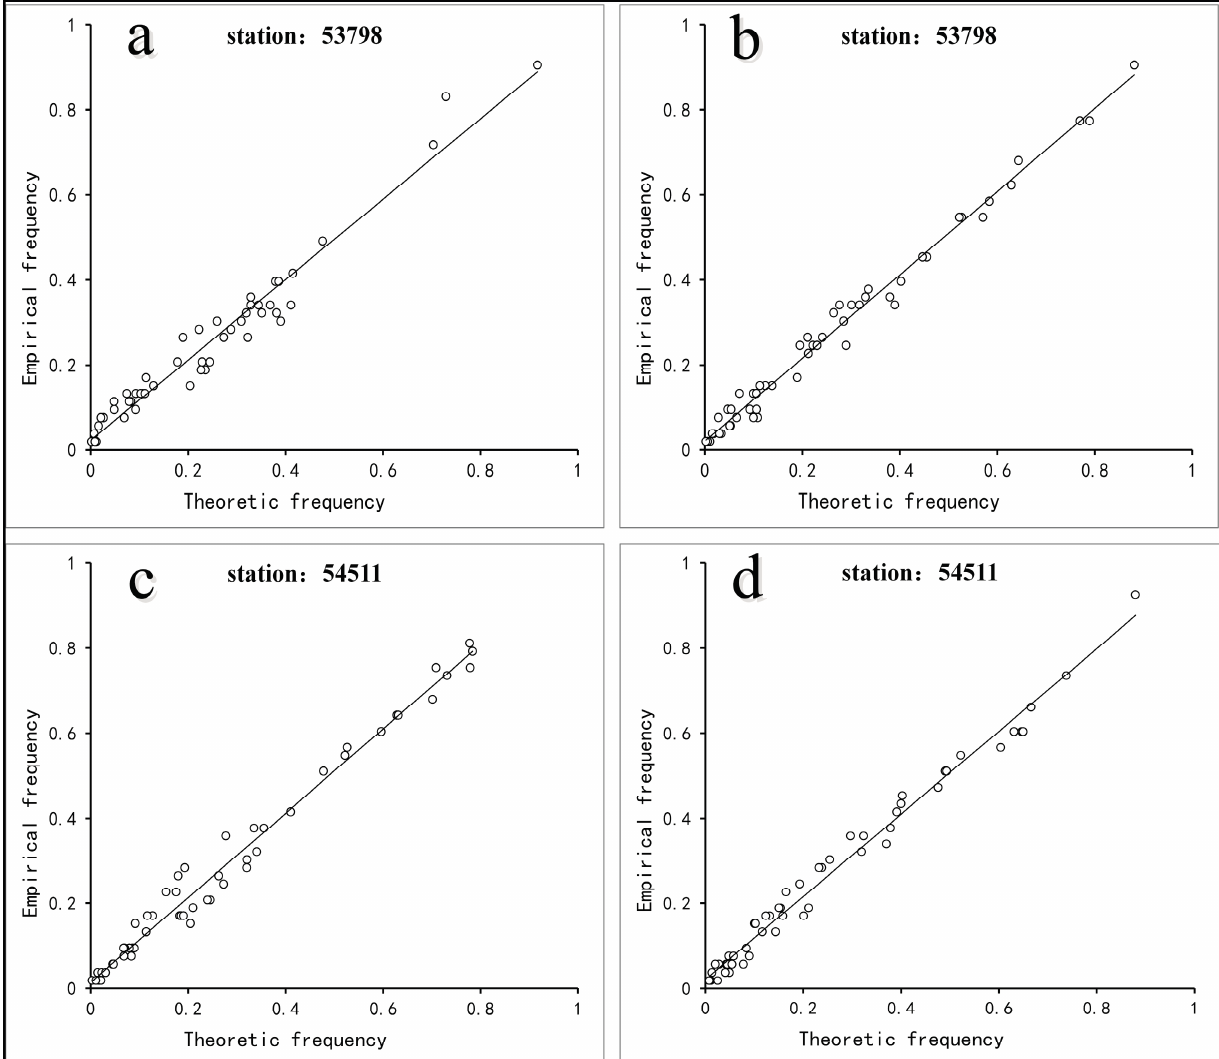
Figure 5. The comparison between empirical frequency and the theoretical frequency of Frank copula distribution at meteorological station 53798 and 54511 (station 53798: ( a ) for spring-summer; ( b ) for summer-autumn; Station 54511: ( c ) for spring-summer; ( d ) for summer-autumn).